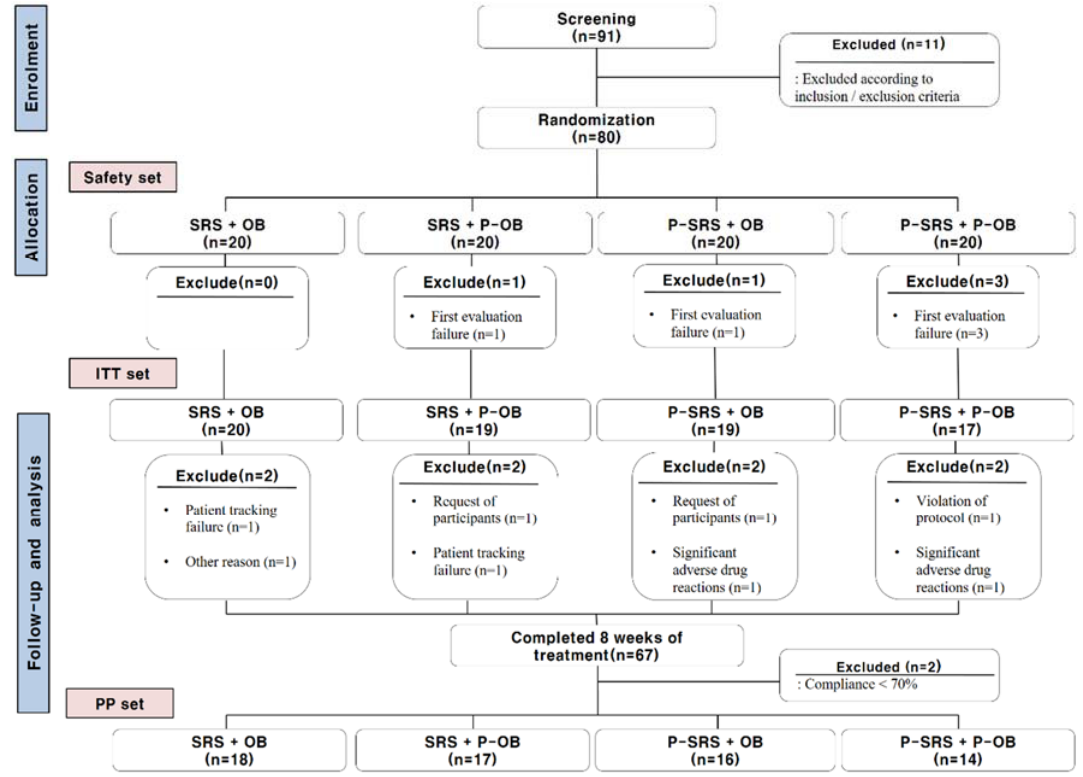
Figure 3. Flow chart of the study. SRS = Samryungbaekchul-san; P = placebo; OB = otilonium bromide; ITT = intent-to-treat; PP = per-protocol.